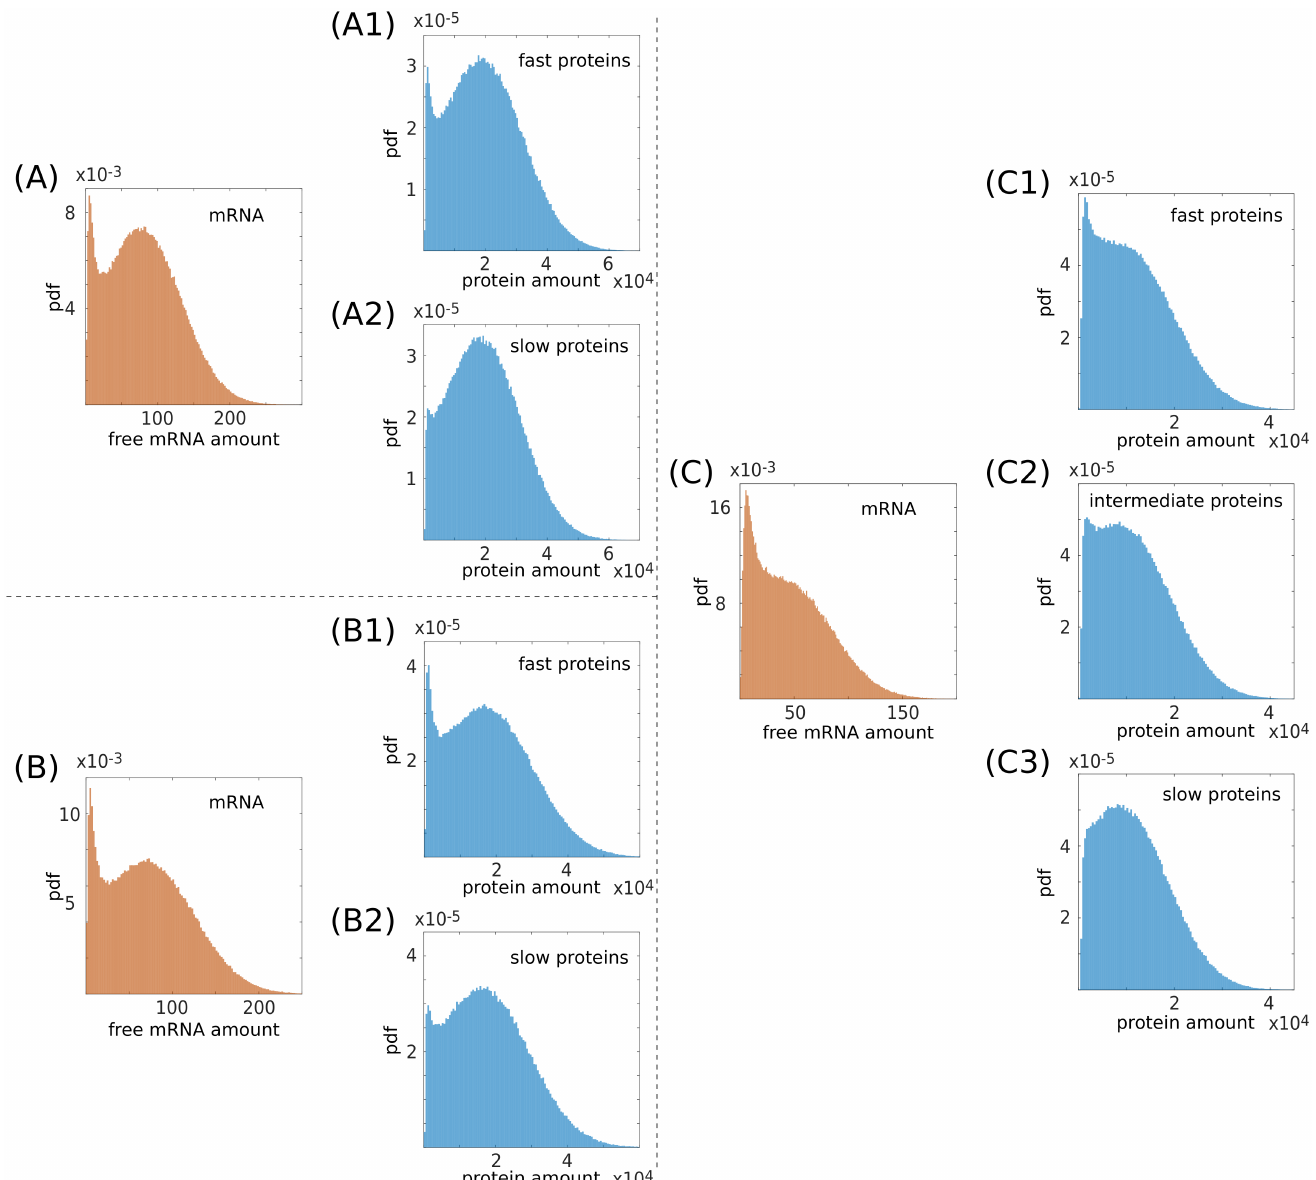
Fig 6. Protein half-life and bimodality. In this panel three conditions (A), (B) and (C) in which the shape of the protein distribution is altered by an increased protein stability are reported. Histograms are the result of numerical simulations. The free mRNA distributions are represented in orange, and the protein distributions in blue, corresponding to different levels of scale separation between the mRNA and protein dynamics. Fast protein distributions are obtained for a protein half life comparable to that of the mRNA; in this condition the state of the protein copies that of the mRNA and the distributions almost coincide. Slow protein distributions are obtained for a protein half life up to 10 times longer than that of the mRNA. As a consequence of the higher protein stability different outcomes can be achieved depending on the level of extrinsic noise, the miRNA-target interaction strength and the proximity to the threshold ( k R ). Starting with a well defined bimodal distribution (A1) and (B1), for a fixed level of extrinsic noise, the repressed peak can be buffered (A2) or not (B2) depending on the value of k . R If the initial distribution is unimodal repressed (C1), for a given range of parameters, it can be converted into a unimodal unrepressed (C3), crossing a bimodal state (C2), by increasing the protein stability. In (A) the parameters are k = 3.1 × 10 −3 nM min −1 , (cid:22) k ¼ 1 : 2 (cid:2) 10 (cid:0) 3 nM min (cid:0) 1 , σ = 2.4 × 10 −4 nM min −1 , g = 1.2 × 10 −2 R S S min −1 , g R = 2.4 × 10 −2 min −1 , g = 1.2 × 10 2 nM −1 min −1 , α = 0.5, k P = 6.0 min −1 , g P = 2.4 × 10 −2 min −1 for (A1) and k P = 6.0 × 10 −1 min −1 , g P = 2.4 × 10 −3 min −1 for (A2). In (B) the parameters are k = 3.0 × 10 −3 nM min −1 , (cid:22) k ¼ 1 : 2 (cid:2) 10 (cid:0) 3 nM min (cid:0) 1 , σ = 2.4 × 10 −4 nM min −1 , g = 1.2 × 10 −2 min −1 , g = 2.4 × 10 −2 min −1 , R S R S g = 1.2 × 10 2 nM − 1 min − 1 , α = 0.5, k P = 6.0 min − 1 , g P = 2.4 × 10 − 2 min − 1 for (B1) and k P = 6.0 × 10 − 1 min − 1 , g P = 2.4 × 10 − 3 min − 1 for (B2). In (C) the parameters are ¼ 1 : 4 (cid:2) 10 (cid:0) 3 nM min (cid:0) 1 , σ = 1.7 × 10 − 4 nM min − 1 , g = 1.2 × 10 − 2 min − 1 , g = 2.4 × 10 − 2 min − 1 , g = 1.2 × 10 2 nM − 1 min − 1 , α = 0.5, k = k R = 3.1 × 10 − 3 nM min − 1 , (cid:22) k S R P S 6.0 min −1 , g P = 2.4 × 10 −2 min −1 for (C1), k P = 3.0min −1 , g P = 1.2 × 10 −2 min −1 for (C2) and k P = 1.2min −1 , g P = 4.8 × 10 −3 min −1 for (C3). The ratio between k P and g P is always kept constant in order to maintain the mean of the protein distributions at a fixed value. Note that we do not present the analytic curves for such cases as the approximation fails to capture subtle features such as the (dis-)appearance of a small peak (see SI).